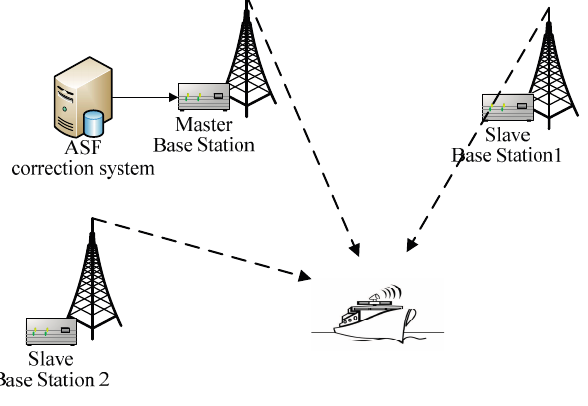
Figure 1. AIS autonomous positioning system